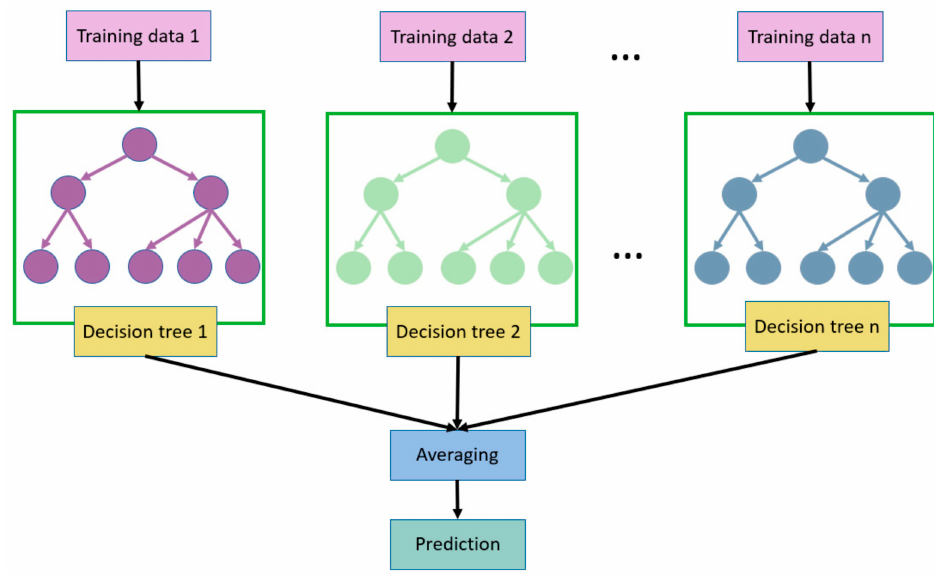
Figure 5. RF algorithm with n decision